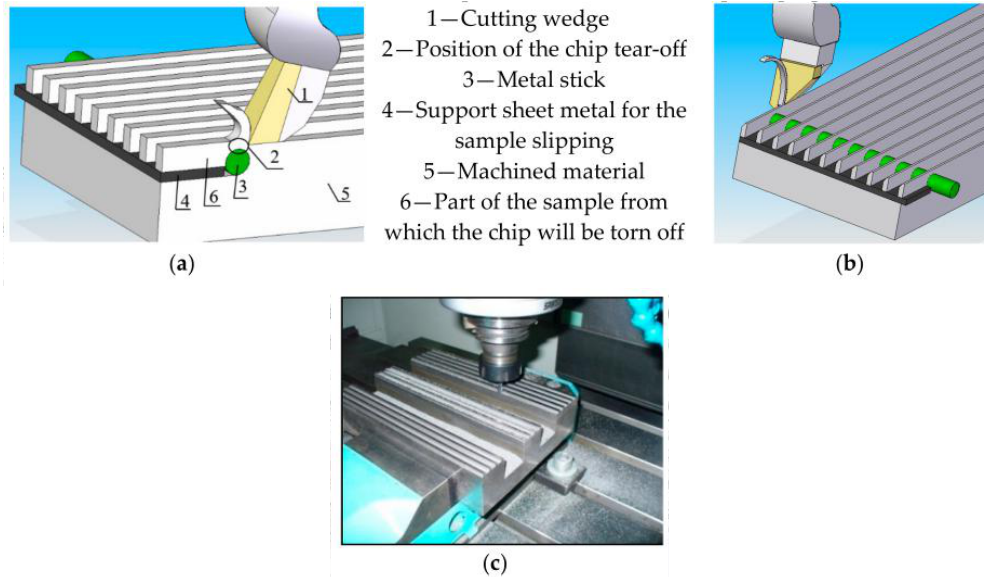
Figure 5. The principle of the designed method for instantaneous contact interruption between a tool and workpiece showing ( a ) orthogonal cutting, ( b ) oblique cutting, ( c ) real